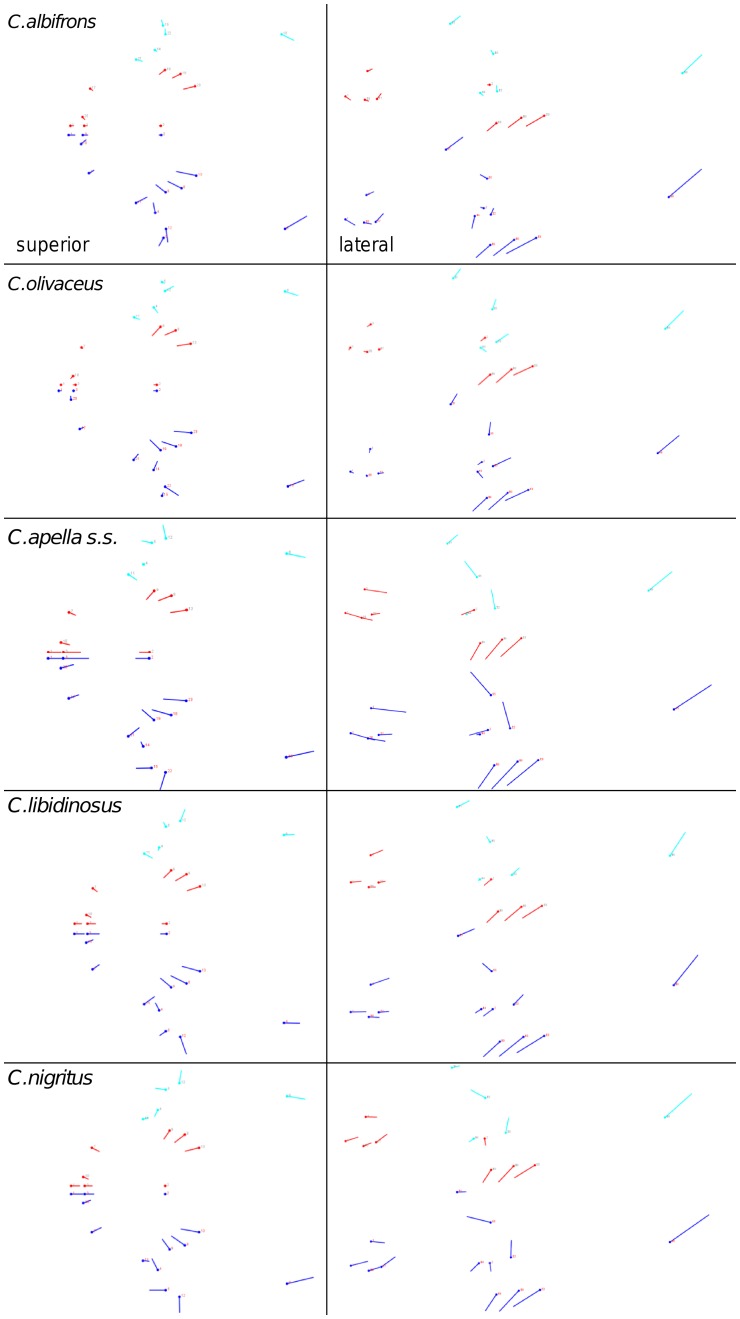
Shape change contained in the allometric oral-zygomatic PLS1 and the allometric PC1.Legend: oral-zygomatic PLS1 blocks colored in red and turquoise; PC1: landmark configuration colored in dark blue.